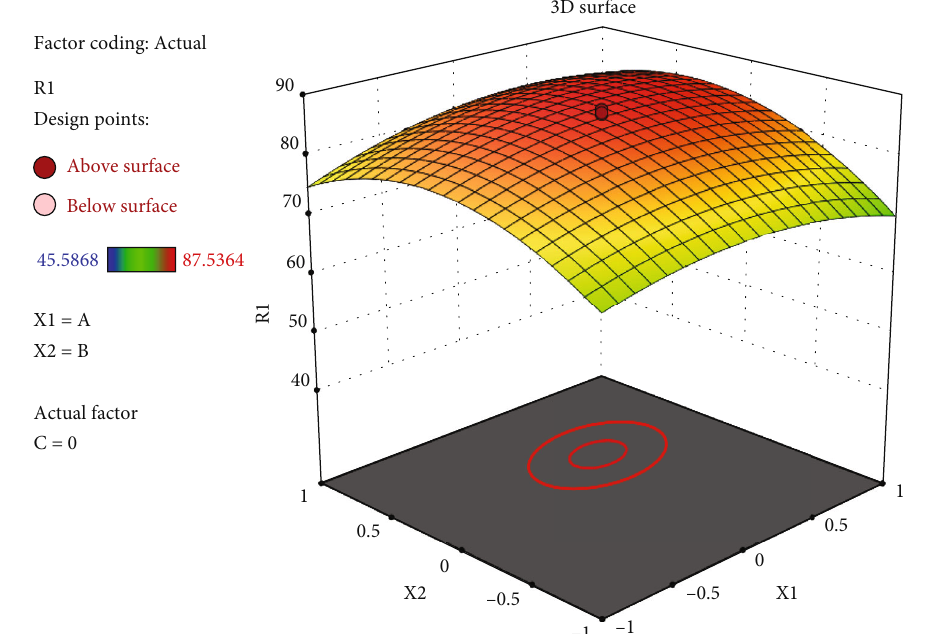
Figure 2: RSM plot: e ff ect of temperature ( X